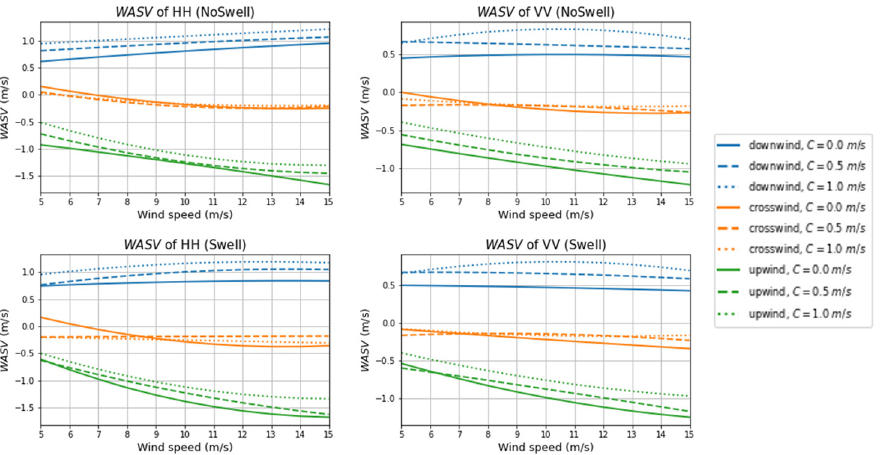
Figure 10. The relationship between WASV and wind speed for HH and VV polarizations. Other input parameters were set to the values indicated in Table 1.